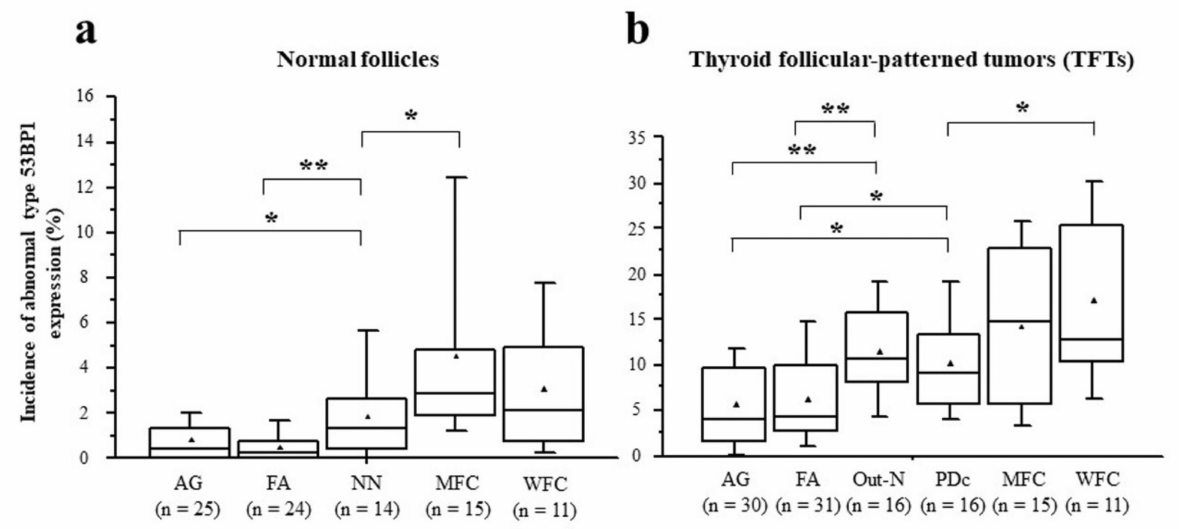
Figure 7. Comparison of median incidences of abnormal type 53BP1 expression in normal follicles surrounding thyroid follicular-patterned tumors (TFTs) ( a ) and in TFTs ( b ) among histological type. * p < 0.05, ** p < 0.005 by Student’s t -test. (cid:78) indicates the mean